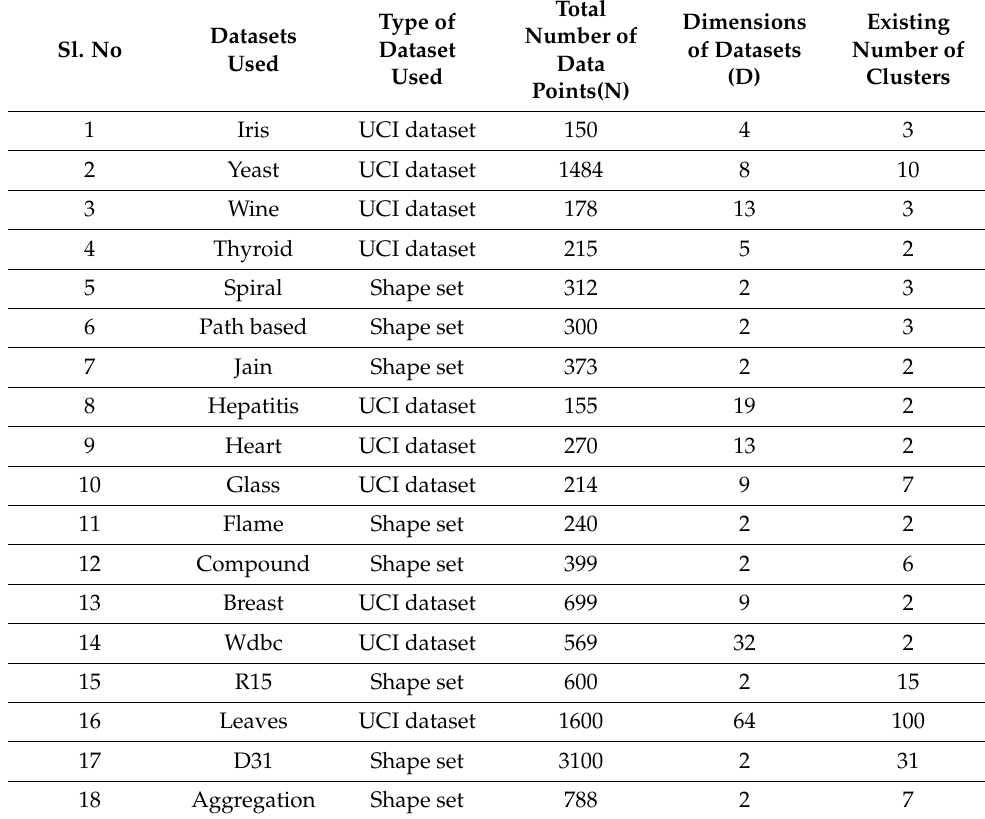
Table 2. Characteristics of the eighteen